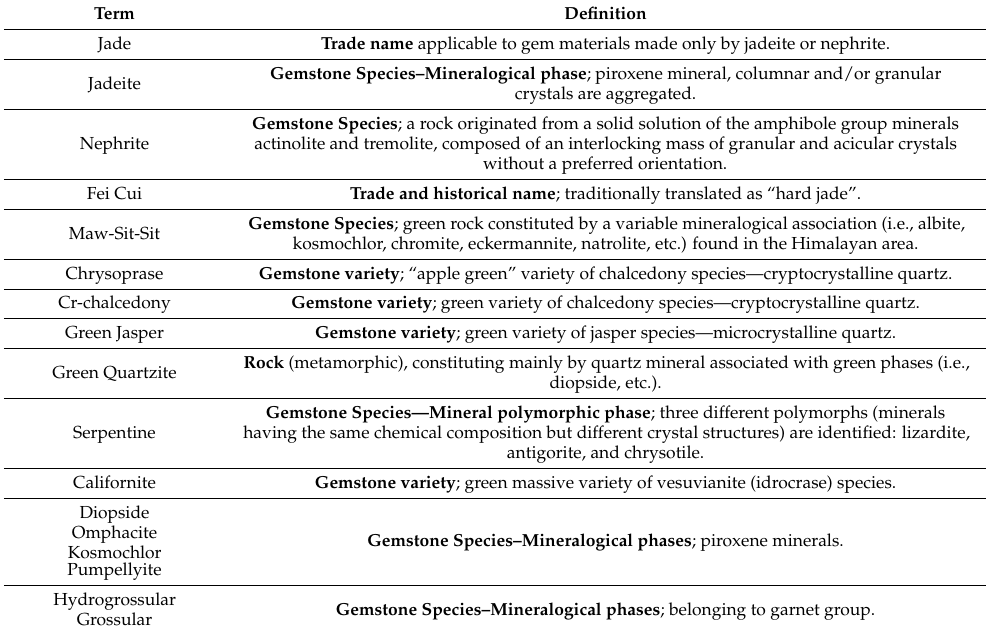
Table 1. The nomenclature of “Green